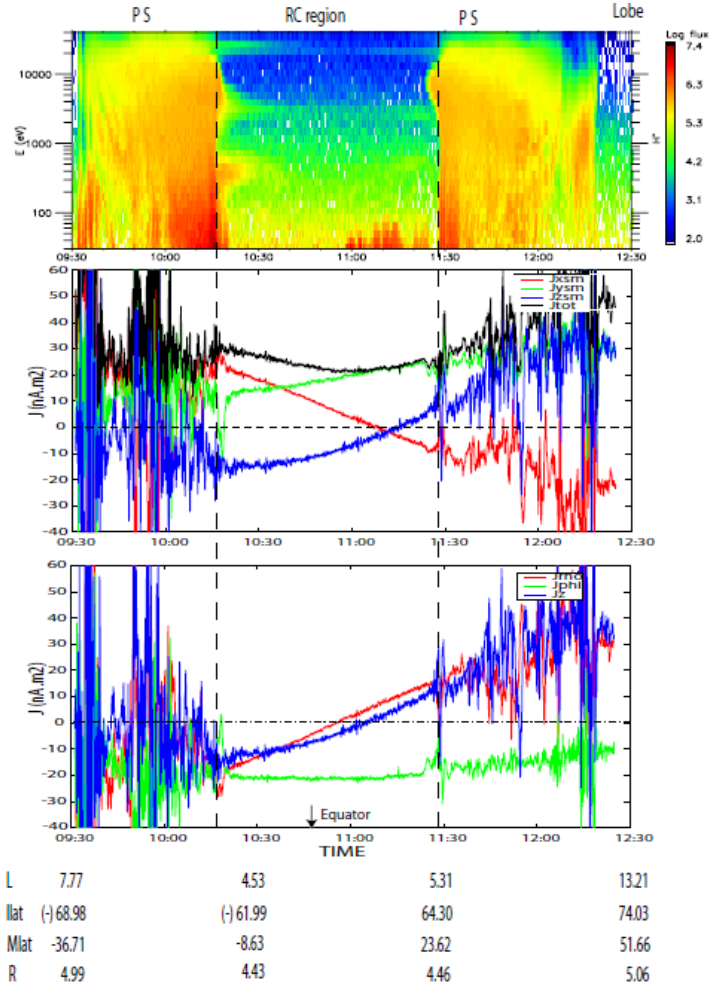
Figure 3. Cluster data for the 18 March 2002 event: H+ energy–time spectrogram for SC4 in particle flux units (ionscm − 2 srskeV), current density components in the SM coordinate system and in nAm − 2 (second panel), and in the local cylindrical coordinate system (bottom panel). Black dashed lines demarcate the ring current region. L shell, invariant latitudes, magnetic latitudes and geocentric distances are indicated below (Fig. 9 from Vallat et al.,